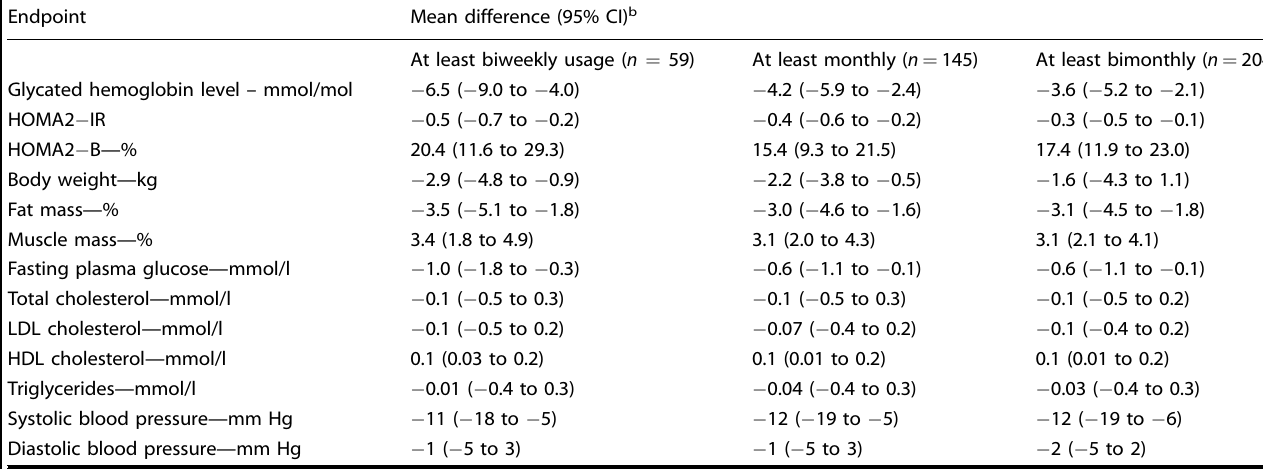
Table 2. Key secondary endpoints a .